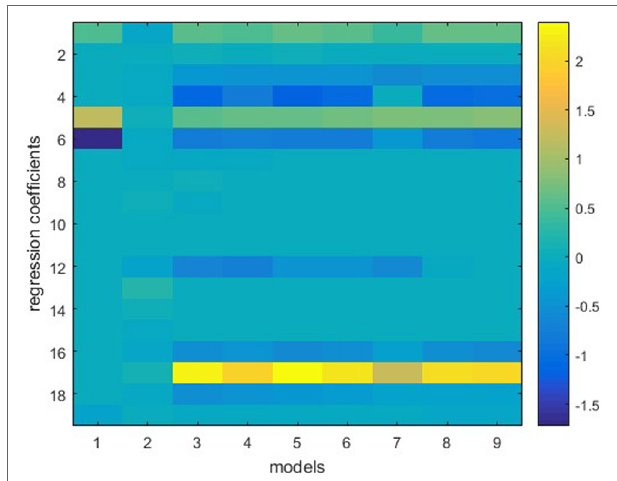
FigUre 1 | Individual models trained on the same dataset. Vertical lines represent regression coefficients of individual models. Models 1–9 (from left to right) refer to stepwise regression, ridge regression, six elastic net regression models with various parameters, and lasso. The vertical bar on the right indicates color mapping. Note that stepwise regression uses the least (four) features and ridge regression uses all features but assigns small weights to the